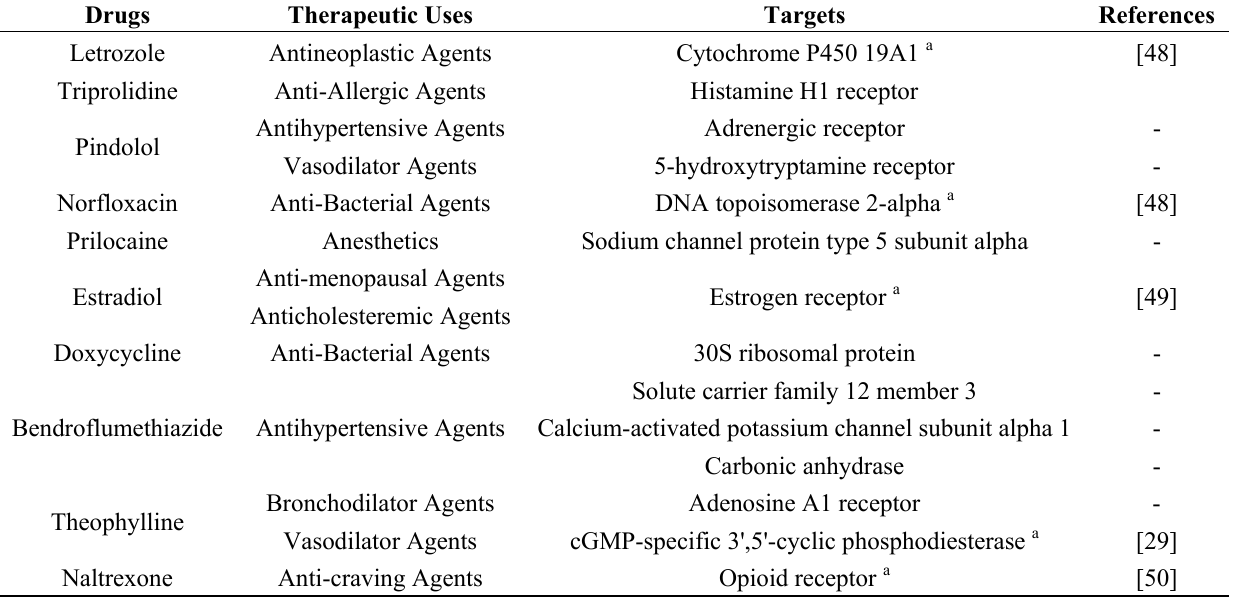
Table 4. Predicted similar drugs and associated targets of ( −